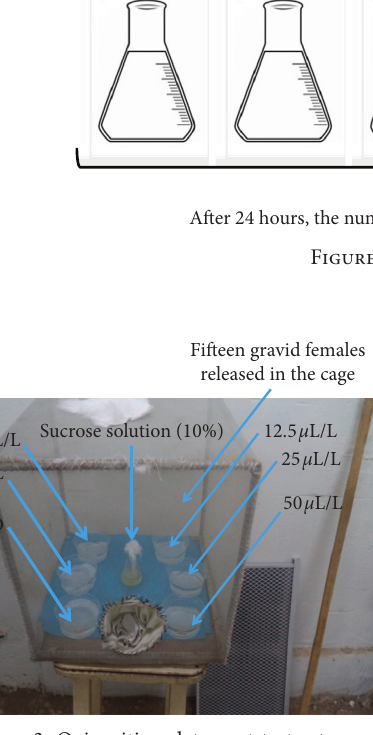
Figure 3: Oviposition deterrent test